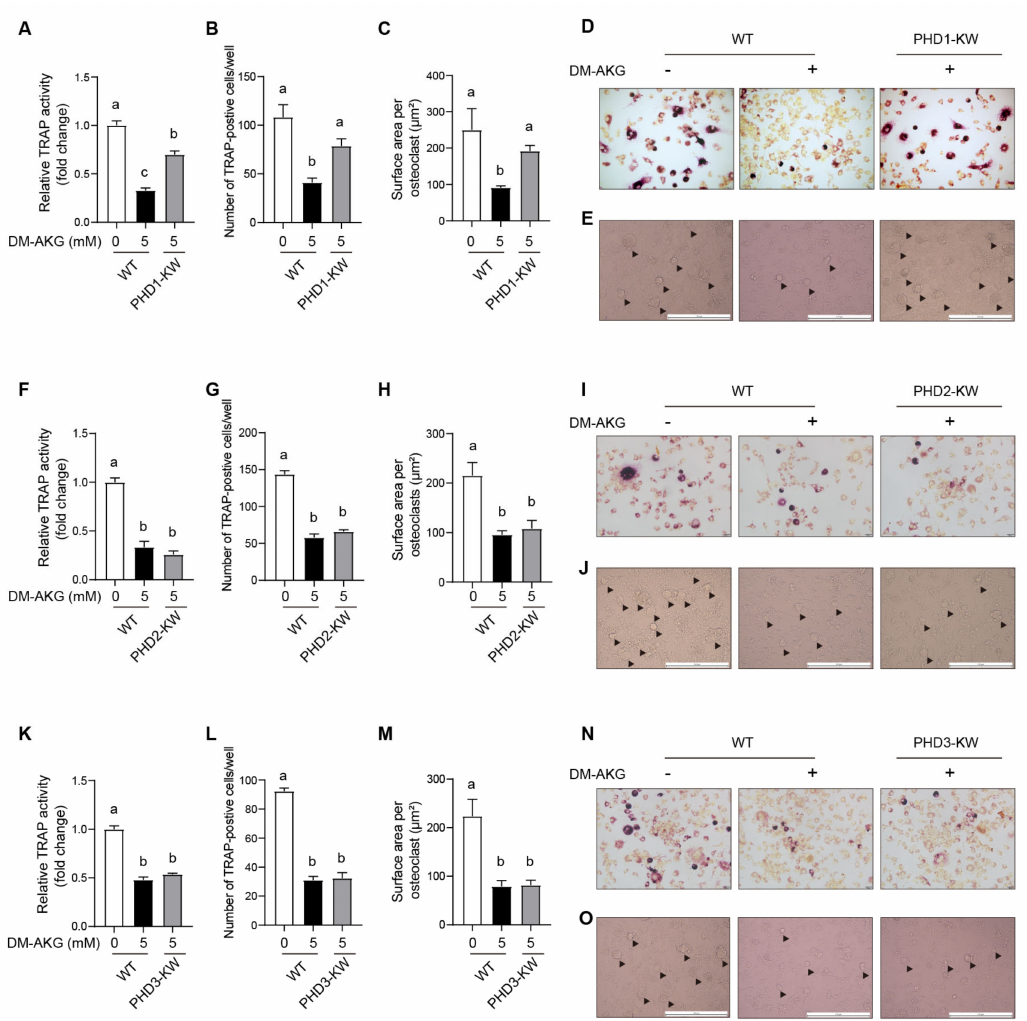
Figure 6. PHD1 deficiency antagonizes the effects of DM-AKG on inhibiting osteoclast differentiation. ( A ) TRAP activity, ( B ) number of TRAP-positive cells, and ( D ) representative photographs of TRAP activity staining in WT and PHD1-deficiency RAW264.7 cells treated with 5 mM DM-AKG and RANKL for 3 days ( n = 3). ( C ) Surface area of multinucleated osteoblasts, and ( E ) representative images of multinucleated osteoclasts from WT and PHD1-deficiency RAW264.7 cells treated with 5 mM DM-AKG and RANKL for 5 days ( n = 3). ( F ) TRAP activity, ( G ) number of TRAP-positive cells, and ( I ) representative photomicrographs of TRAP activity staining in WT and PHD2-deficiency RAW264.7 cells treated with 5 mM DM-AKG and RANKL for 3 days ( n = 3). ( H ) Surface area of multinucleated osteoblasts, and ( J ) representative images of multinucleated osteoclasts from WT and PHD2-deficiency RAW264.7 cells treated with 5 mM DM-AKG and RANKL for 5 days ( n = 3). ( K ) TRAP activity, ( L ) number of TRAP-positive cells, and ( N ) representative photomicrographs of TRAP activity staining WT and PHD3-deficiency RAW264.7 cells treated with 5 mM DM-AKG and RANKL for 3 days ( n = 3). ( M ) Surface area of multinucleated osteoblasts, and ( O ) representative images of multinucleated osteoclasts from WT and PHD3-deficiency RAW264.7 cells treated with 5 mM DM-AKG and RANKL for 5 days ( n = 3). The osteoclasts were indicated by black triangles. All data were presented as means ± SEM. No matching letters between the two groups point to a significant